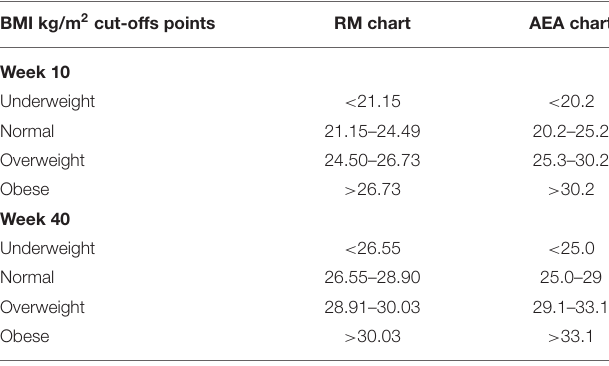
TABLE 1 | Body mass index (BMI) kg/m 2 cut-off points of the RM chart and the AEA chart for the nutritional classification of women at the beginning and at the end of pregnancy ( 11,